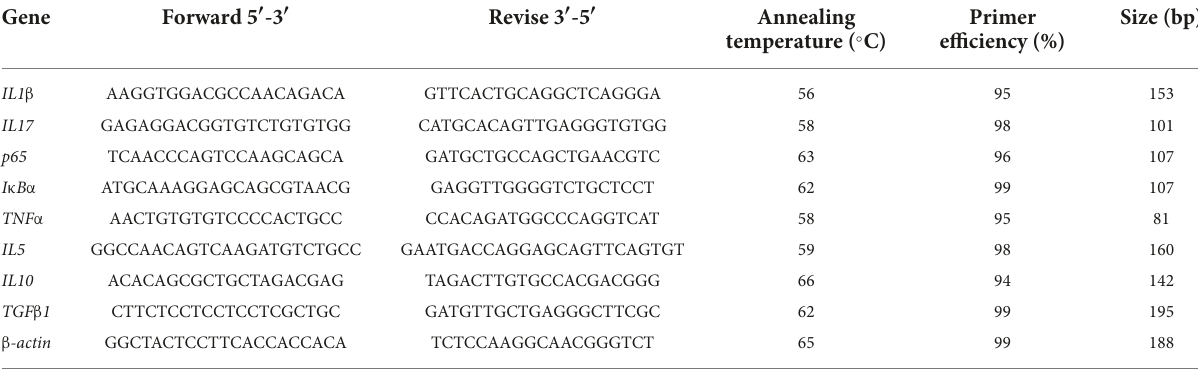
TABLE 2 PCR primers for gut immune-related genes of